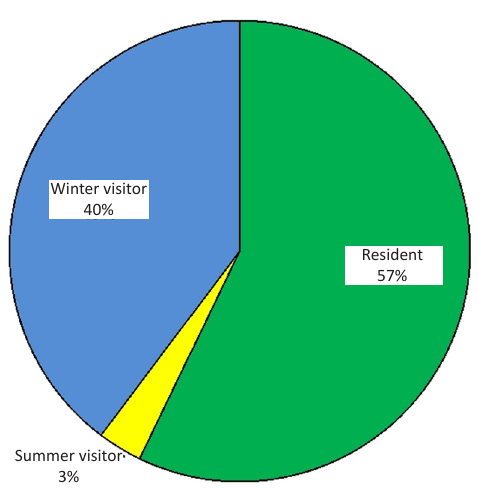
Figure 2. Status of the birds of Sariska Tiger Reserve surveyed during